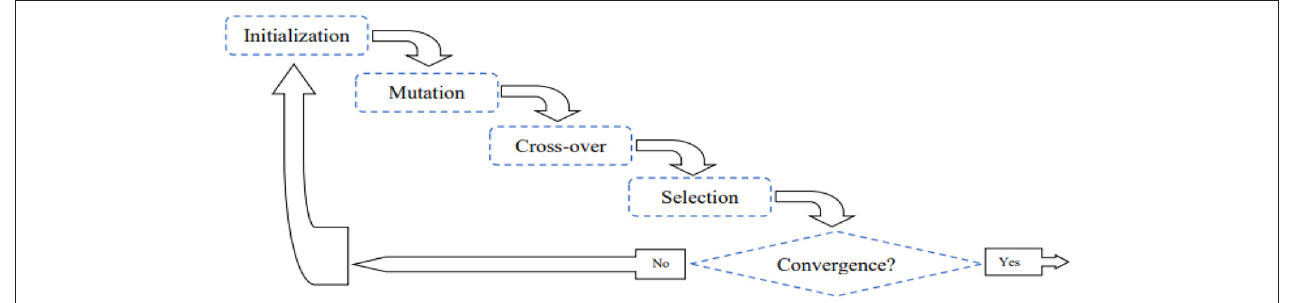
FIGURE 1 | The iterative cycle of differential evolution